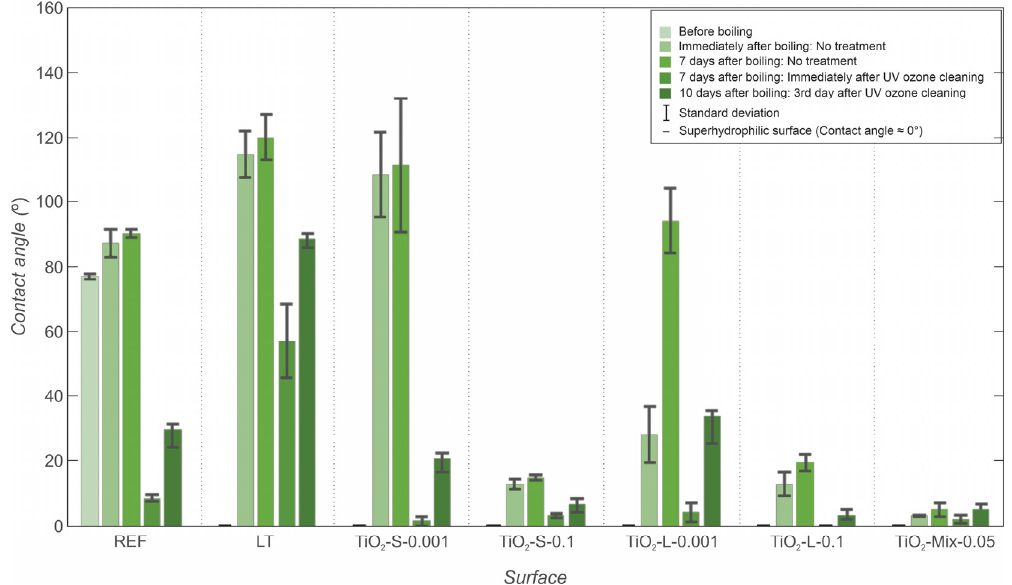
Figure 12. Static contact angle measurements on all surfaces before boiling, after boiling, and after storage. after